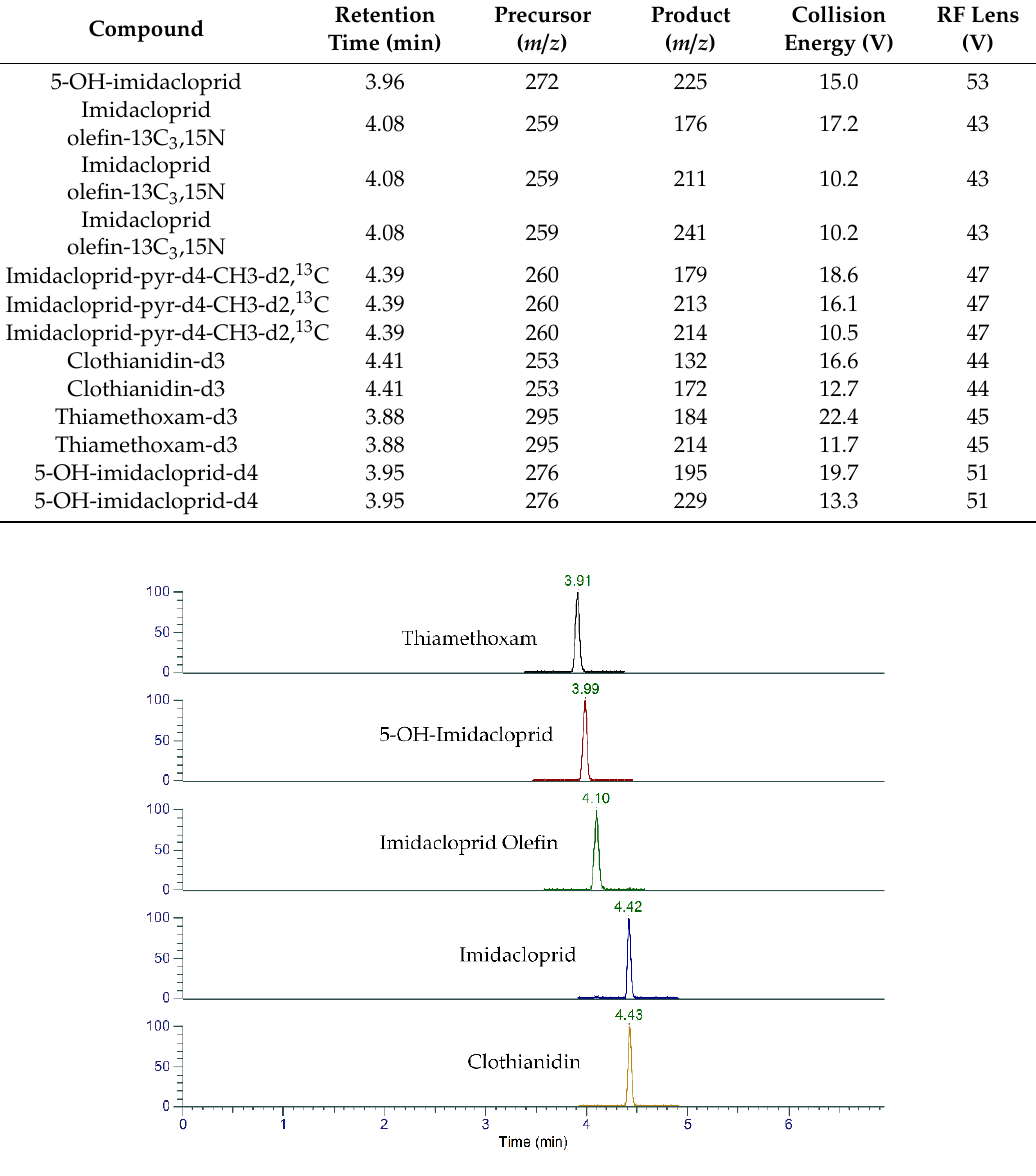
Figure 1. The liquid chromatography tandem mass spectrometry (LC-MS / MS) chromatogram of five neonicotinoids spiked into milkweed leaf tissue extract at 40 ng / g. Across the chromatographic peak, 10 to 12 data points were obtained.